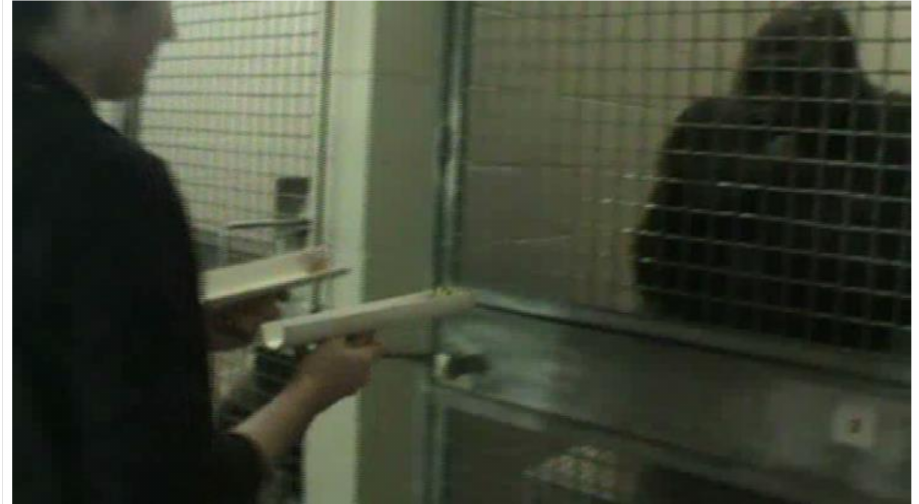
Figure 2. Still from video of manual preference test with